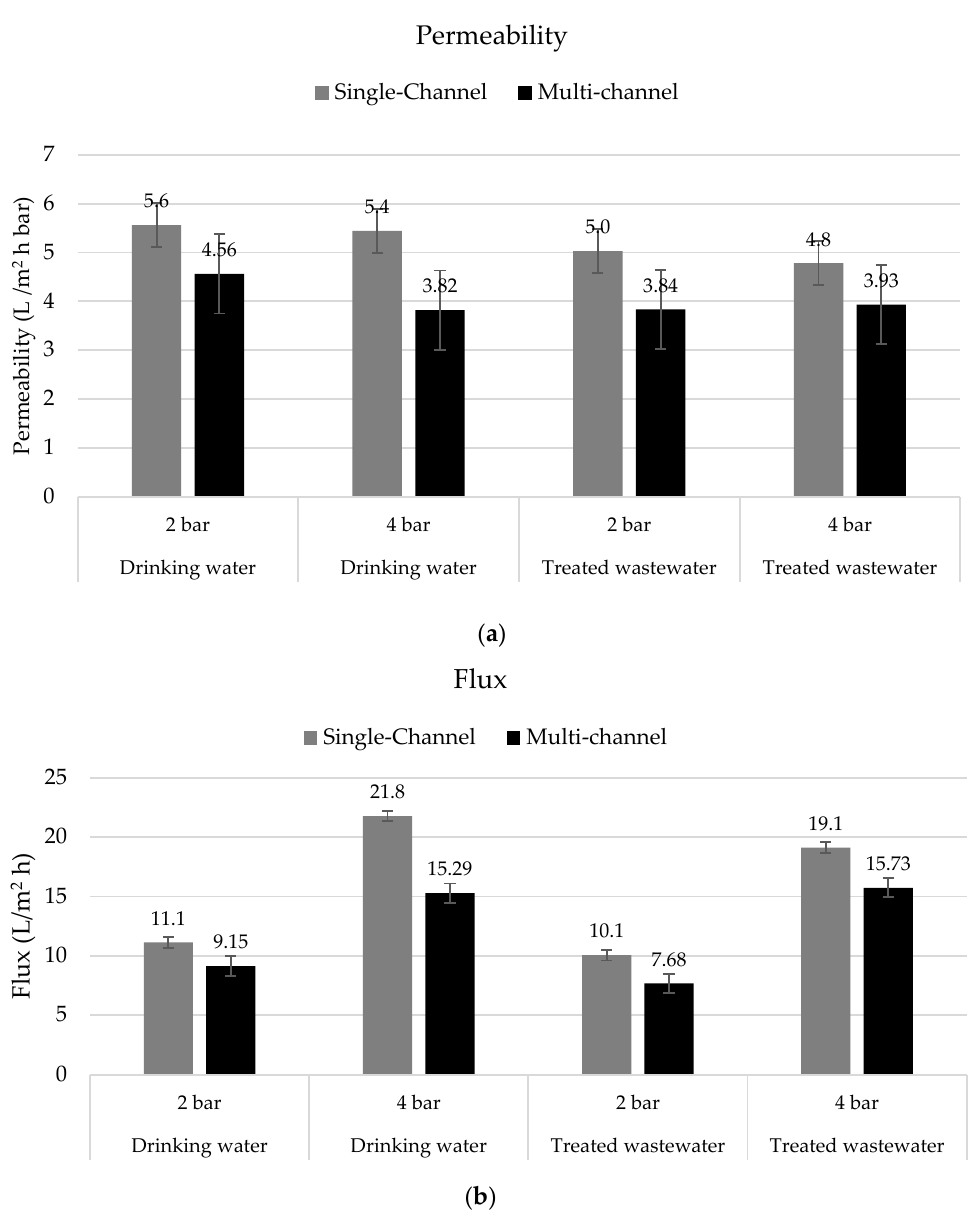
Figure 8. ( a ) Permeability in L/m 2 h bar and ( b ) flux in L/m 2 h in tests with drinking water (n = 3) and treated wastewater (n = 3 – 6) with single-channel hybrid membranes and multi-channel hybrid membranes under different TMPs at 15°C.